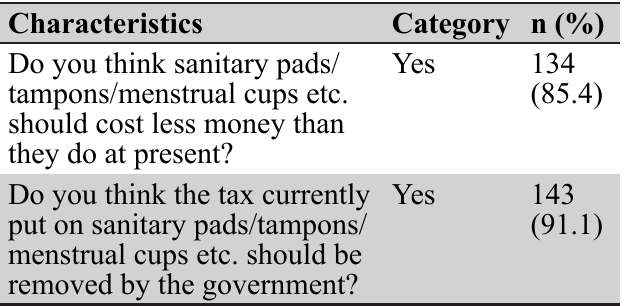
Table 3: Participants’ perception on cost of menstruation (N=157).